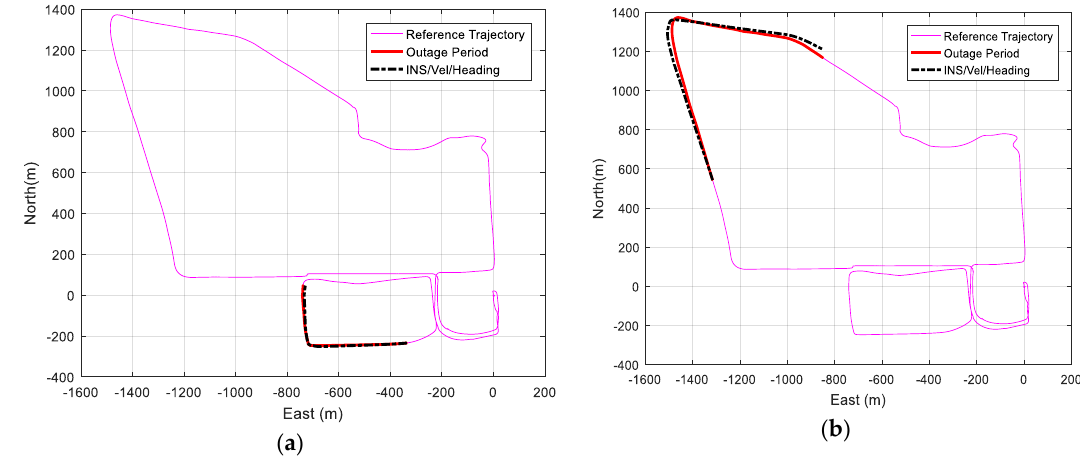
Figure 12. ( a ) Trajectory IMU/ fully-compensated heading change update/velocity update integrated navigation solution for 60 s GNSS signal outage for a sample outage region. ( b ) Trajectory IMU/ fully-compensated heading change update/velocity update integrated navigation solution for 120 s GNSS signal outage for a sample outage region.